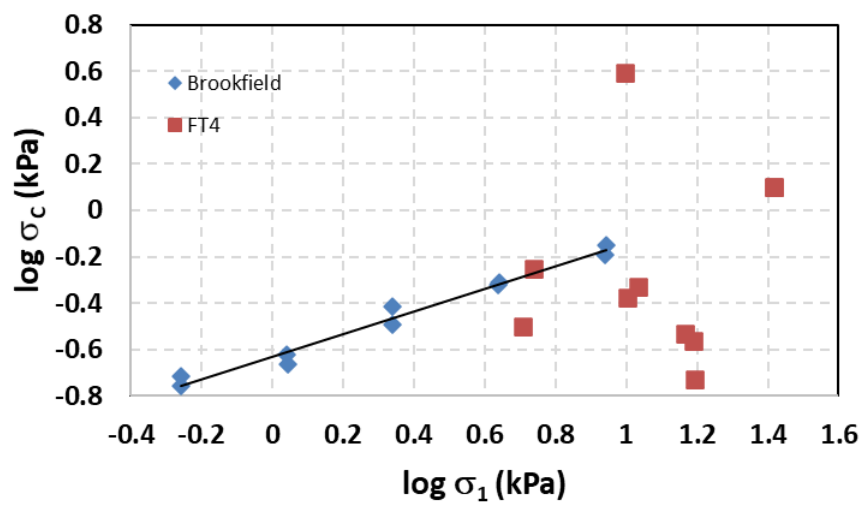
Figure 12. Flow function of Easytab. Table 2. Comparison of the flow functions obtained by the PFT and FT4 for the test